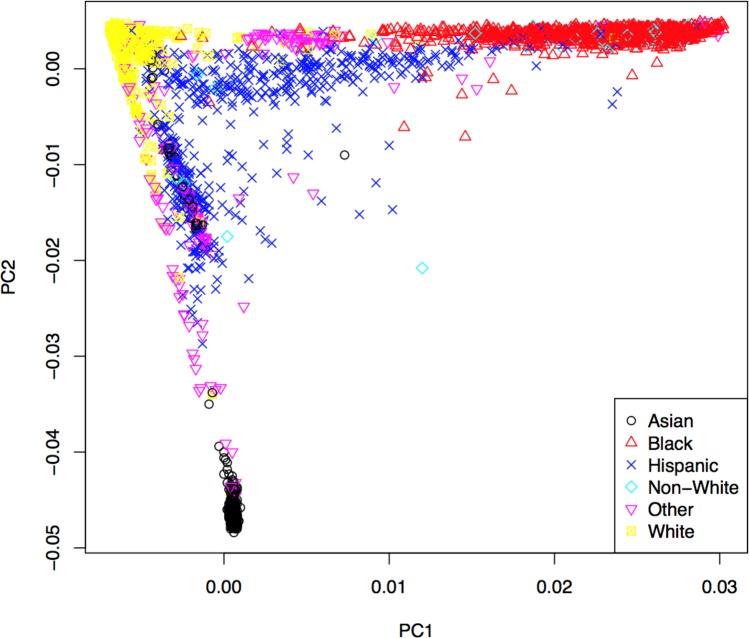
First two principal components with markers indicating self-reported ethnic backgrounds.